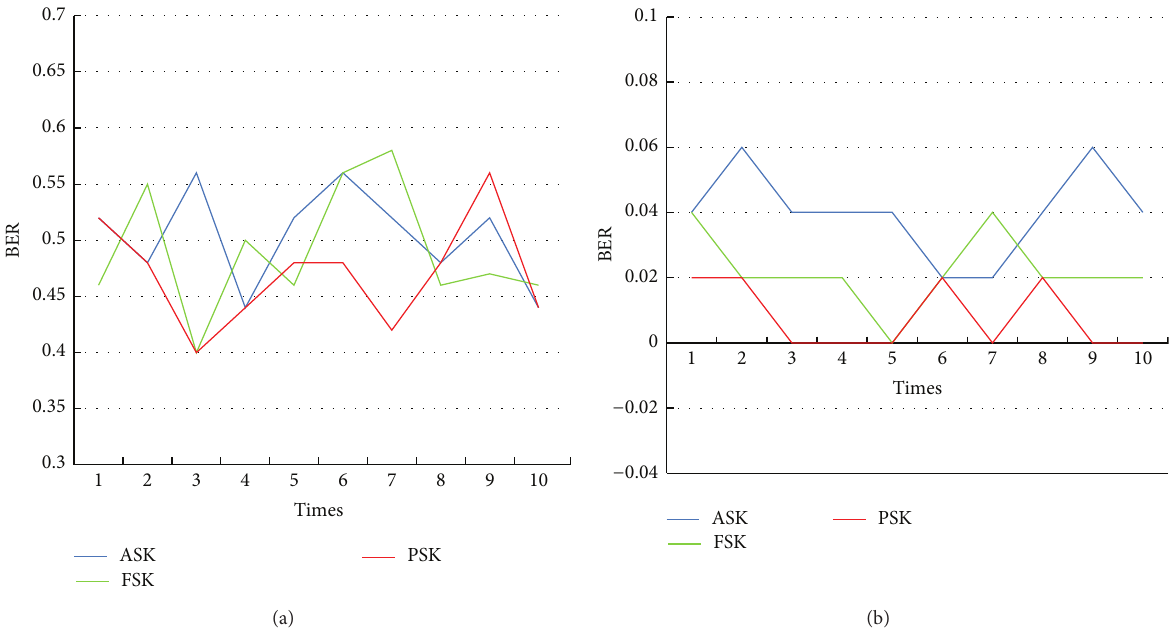
Figure 6: The BER simulation curves of ASK-, FSK-, and PSK-modulated data in the single- and dual-receiver modes. (a) Single-receiver mode, (b) dual-receiver mode.